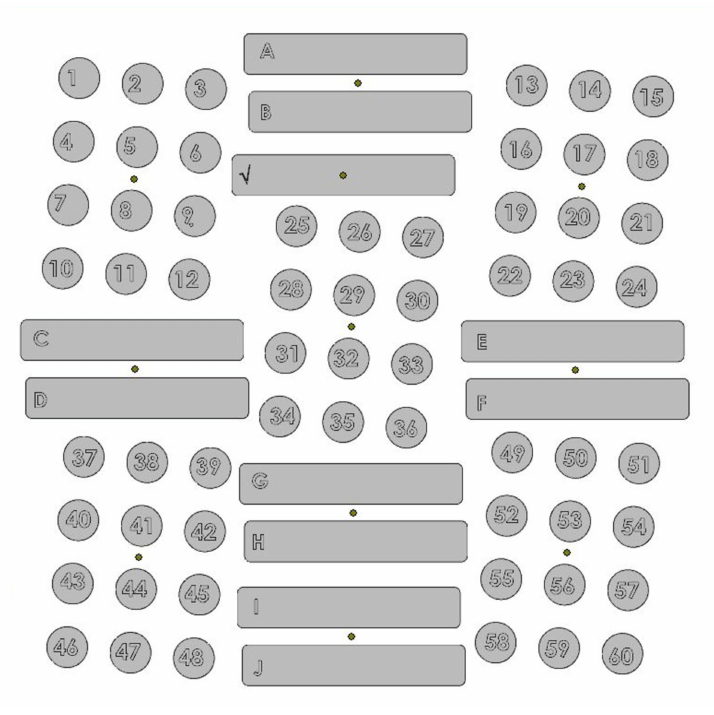
Figure 3. Build plate print layout.